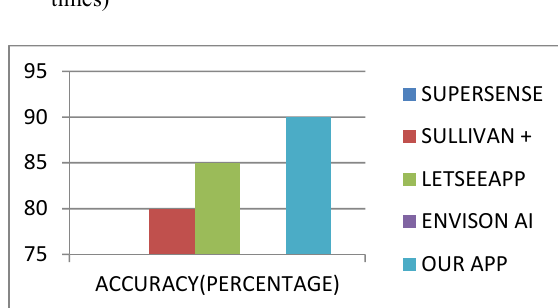
Fig 14 - Accuracy of each application for text recognition Note – the testing was done indoor under tube light (unnatural but ample brightness) and may vary according to the surrounding environmental condition